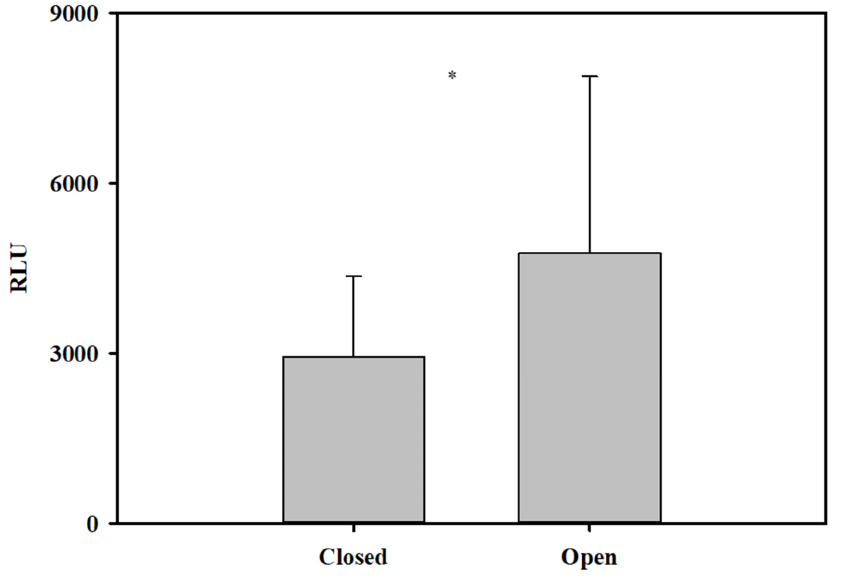
Figure 6. Comparison of relative light unit (RLU) values in the closed- and open-loop soilless cultures at the end of the commercial farm. An asterisk indicates significant differences (* p < 0.05 by t